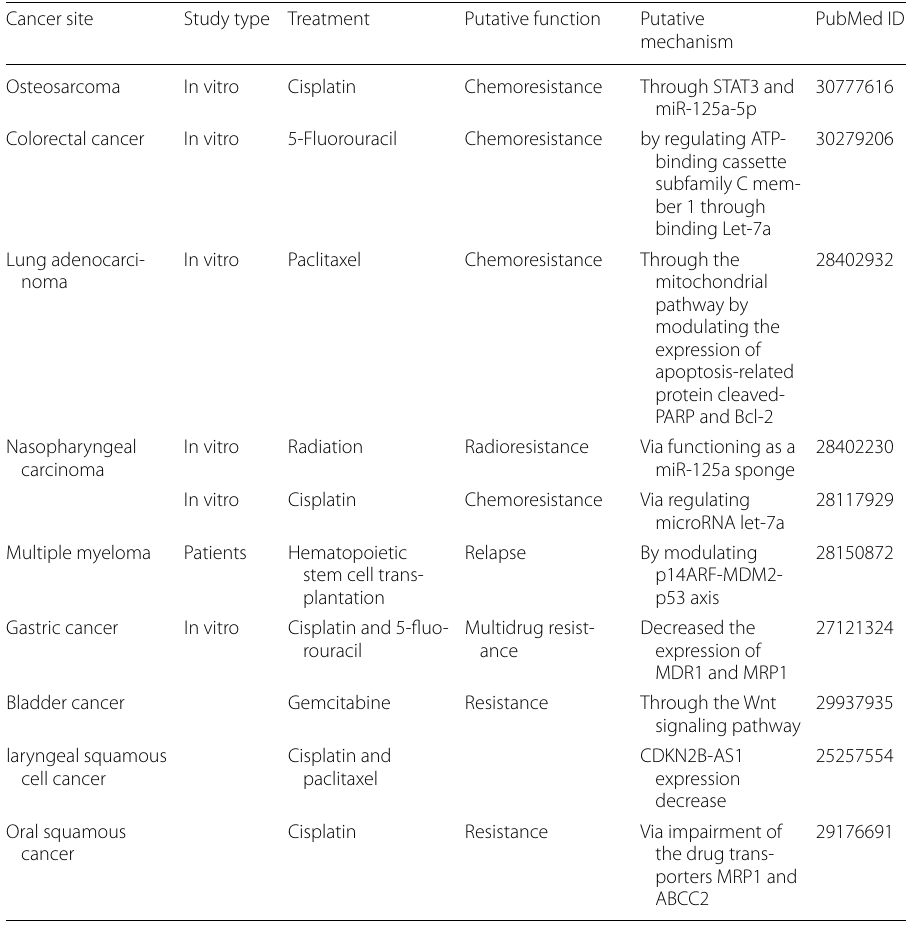
Table 4 Publications on the role of CDKN2B-AS1 with treatment resistance in cancer Cancer